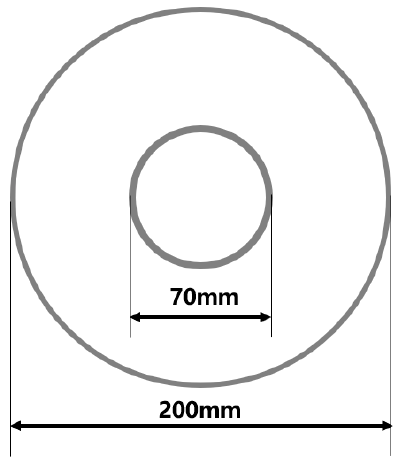
Figure 24. The diameter changes of the target part in this process scheme.